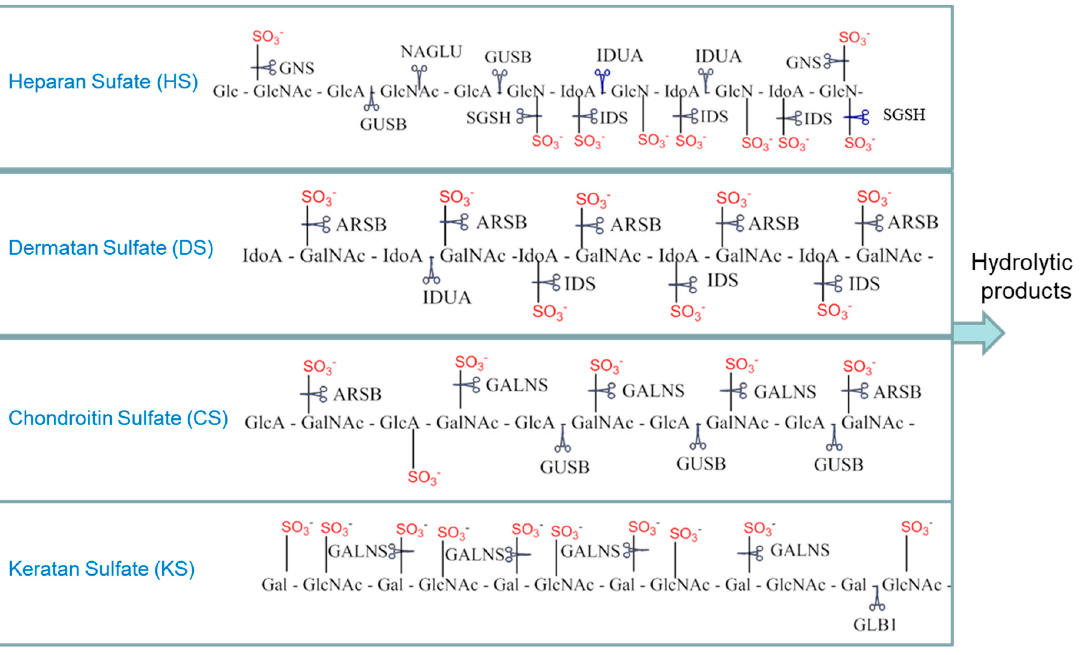
Table 1. Summary of MPS subtypes with published fluorescent screening assays available.